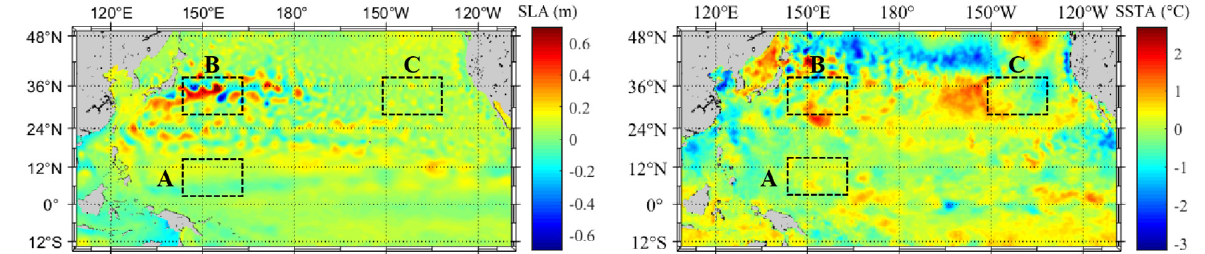
Figure 3. The monthly average SLA and SSTA in July are shown in the left and right panels, respec- tively. Areas A, B, and C which are located in the equator region, KE, and Northeast Paci fi c Ocean are marked as dashed rectangles.